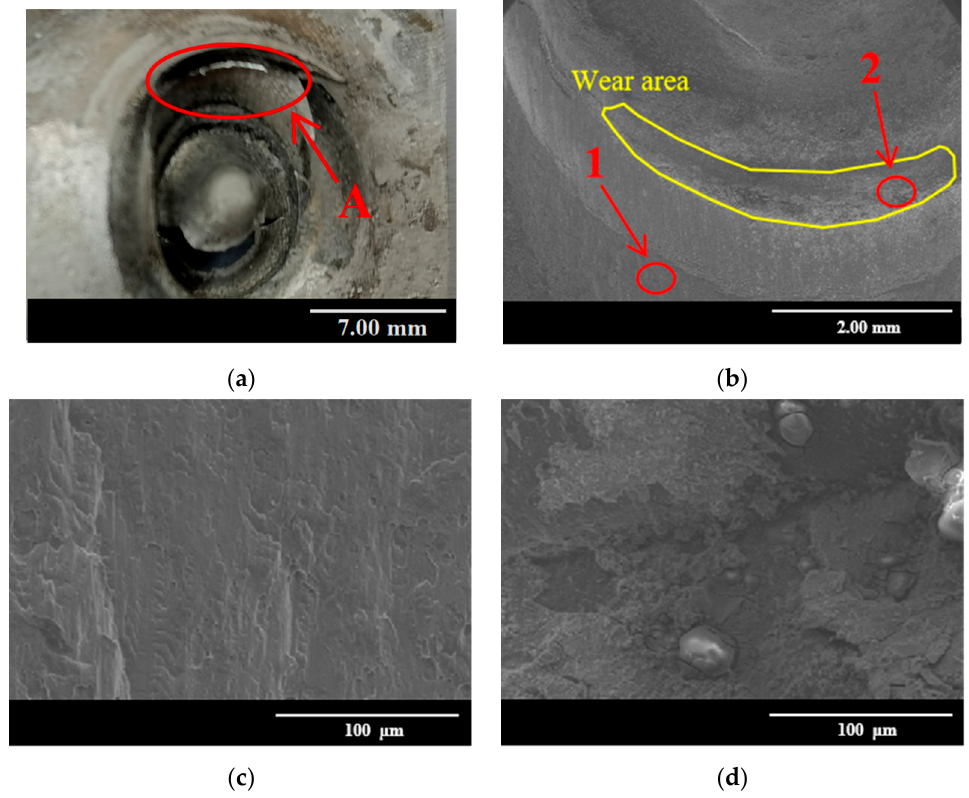
Figure 8. Tensile fracture morphologies of joints after 7 weeks of corrosion: ( a ) macroscopic morphology; ( b ) enlarged view of area A; ( c ) enlarged view of area 1; ( d ) enlarged view of area 2.